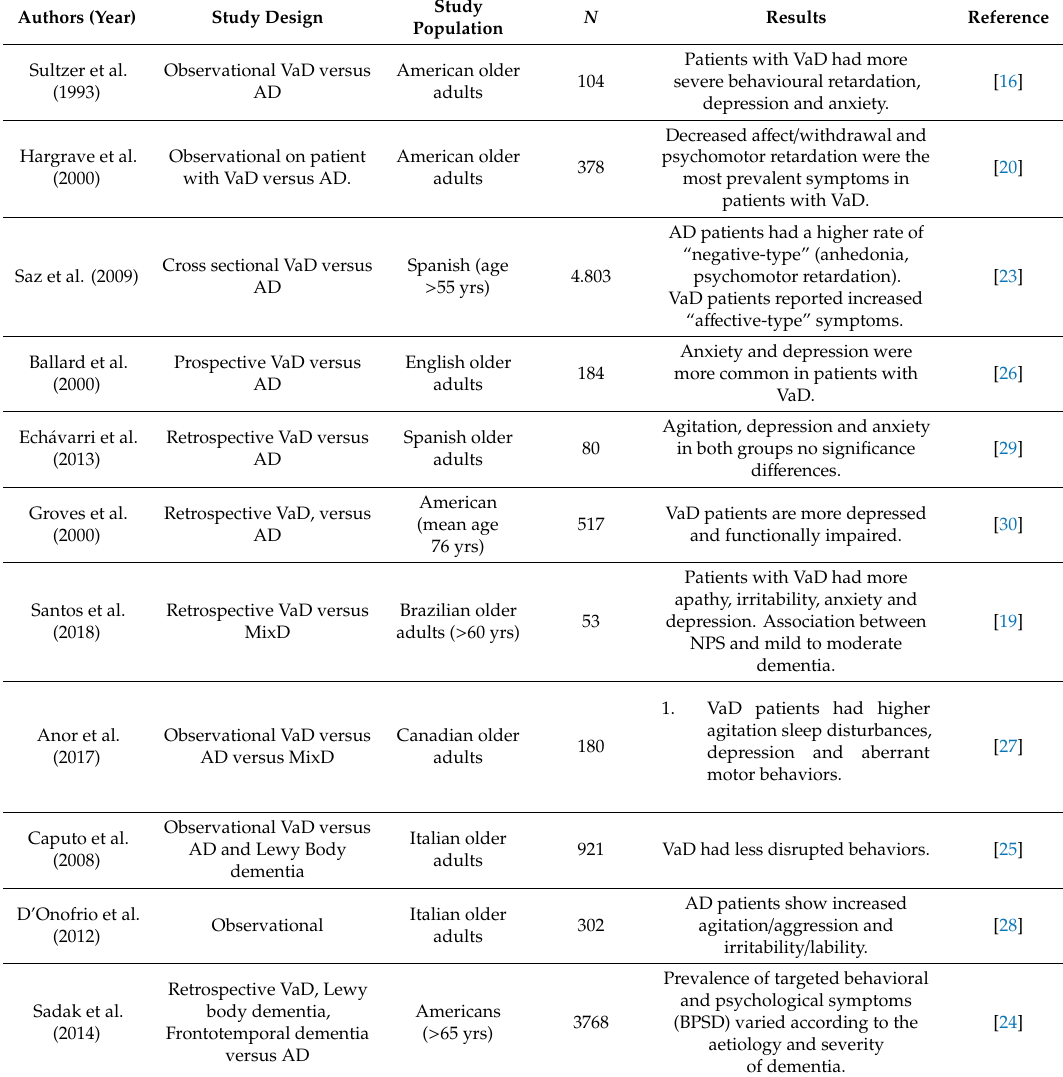
Table 1. Summary of the evidence on the di ff erent neuropsychiatric symptoms associated with vascular dementia (VaD), Alzheimer’ s disease (AD) and mixed dementia (MixD) sub